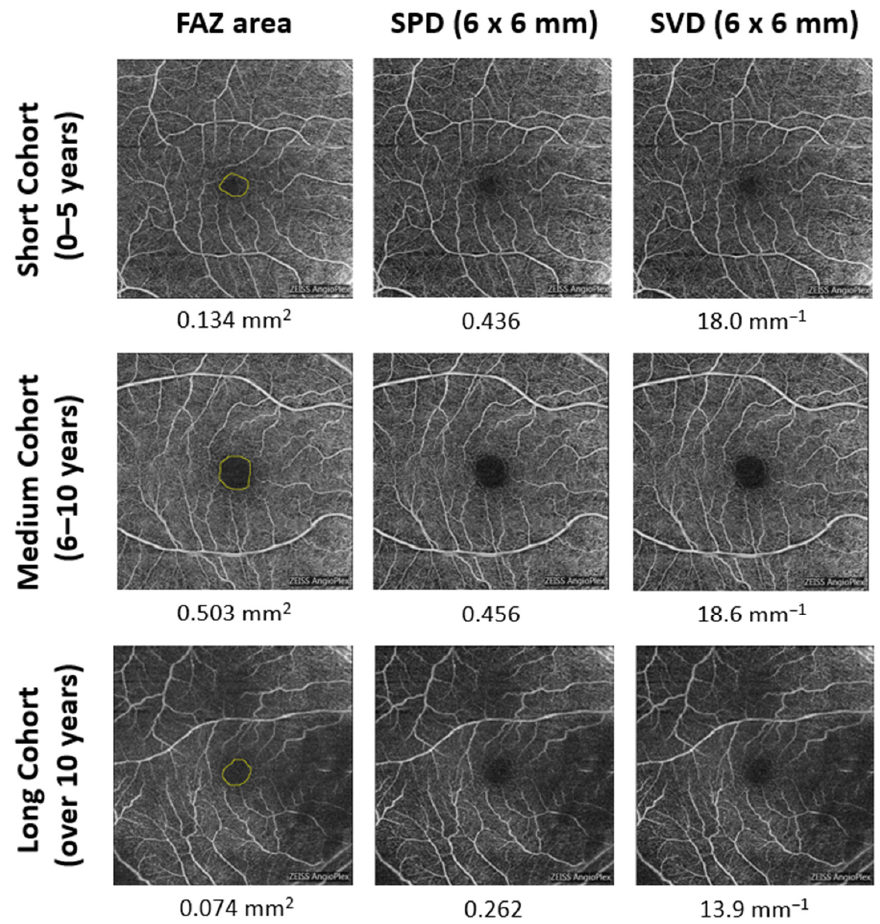
Figure 1. OCTA image acquisition from superficial capillary plexus. Each row shows a representative participant from each group: short cohort (0–5 years DM duration), medium cohort (6–10 years DM duration), and long cohort (greater than 10 years DM duration). Each column shows the quantitative OCTA parameters: FAZ area, SPD in the 6 mm patch, and SVD in the 6 mm patch. The yellow circle in the first column outlines the FAZ border.